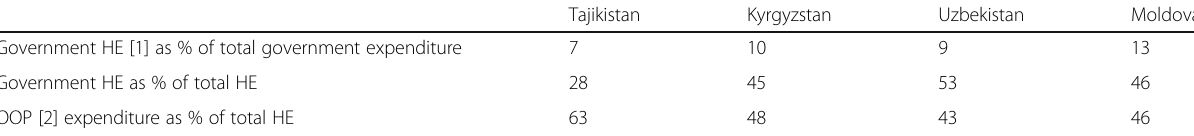
Table 1 Health expenditure in Tajikistan and a selection of post-Soviet low- and and lower-middle-income countries